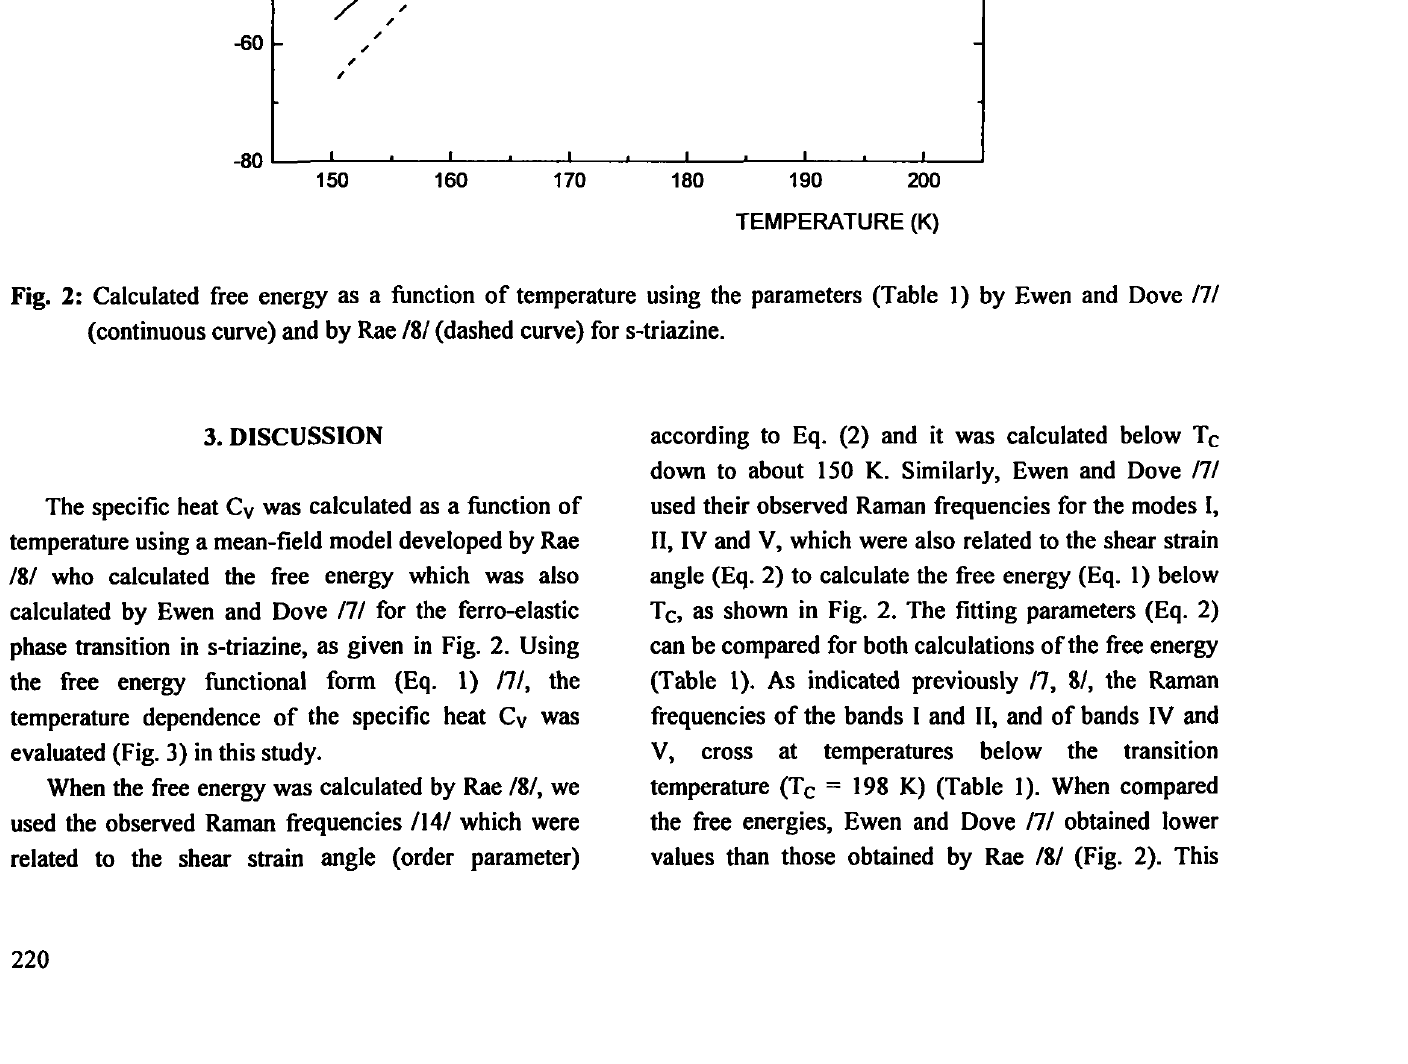
Fig. 2: Calculated free energy as a function of temperature using the parameters (Table 1) by Ewen and Dove ΠI (continuous curve) and by Rae /8/ (dashed curve) for